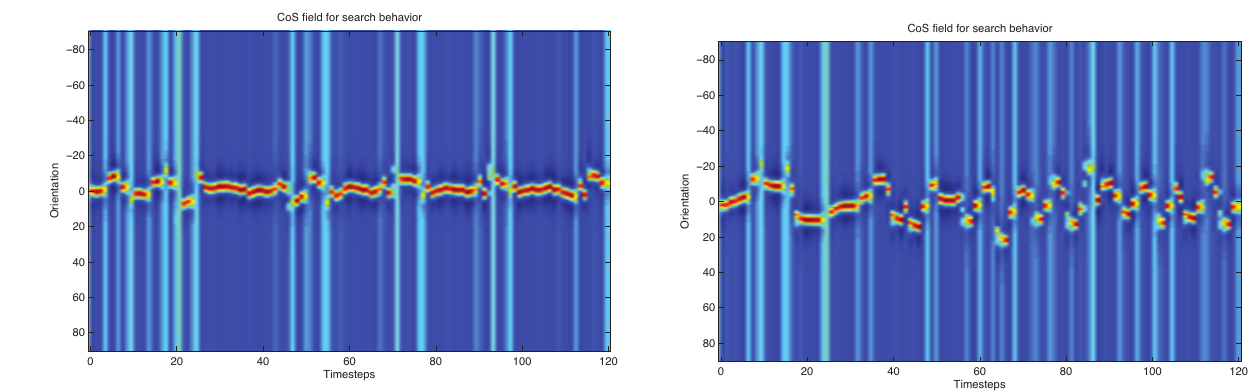
Figure 8. Activity of ordinal nodes for all elementary behaviors when the Ap- proach behavior is explored first.